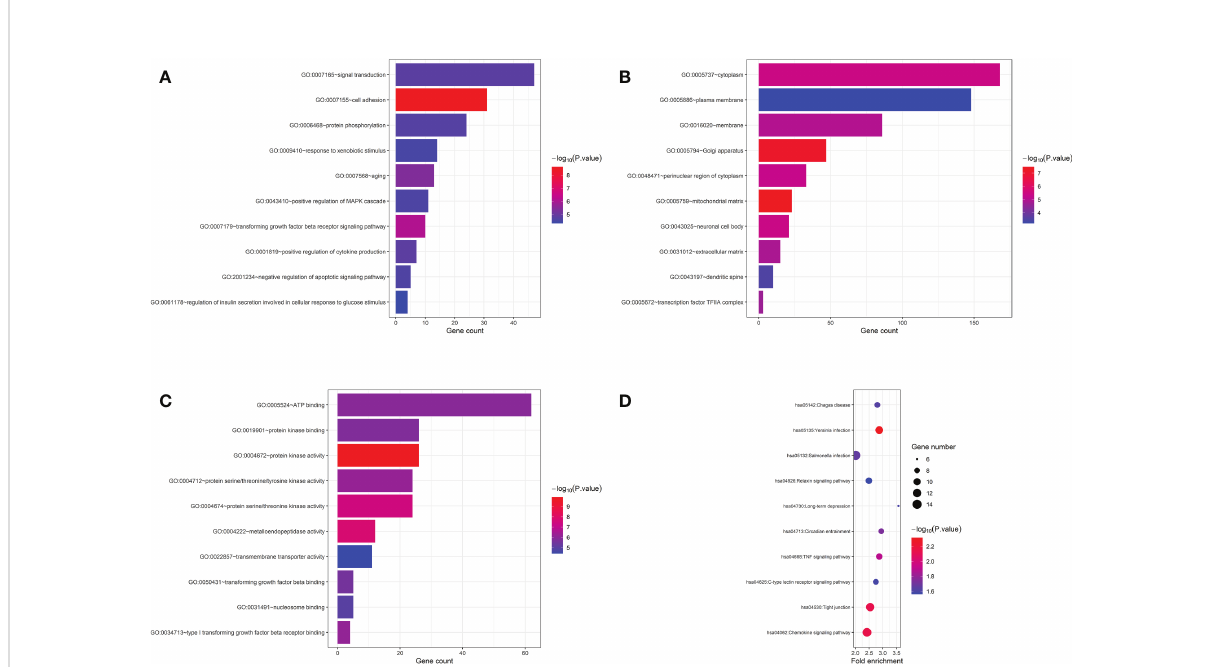
FIGURE 3 GO and pathway enrichment analysis of genes with P<0.05 in gene-based analysis. (A) top 10 biological process GO terms. (B) top 10 cellular component GO terms. (C) top 10 molecular function GO terms. (D) top 10 KEGG pathway terms.